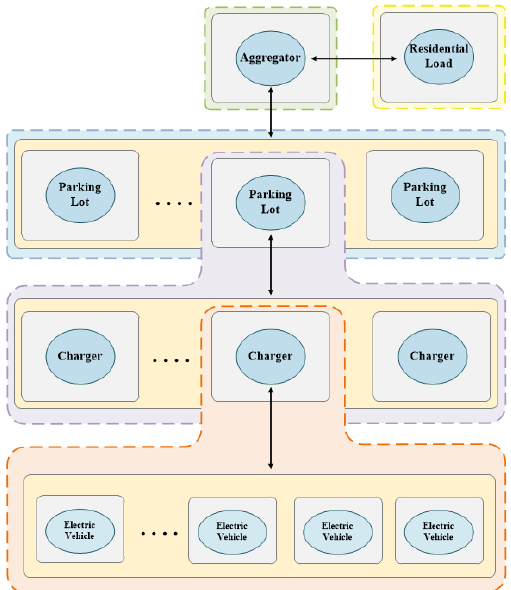
Figure 3. The proposed hierarchical structure of EV parking lots.